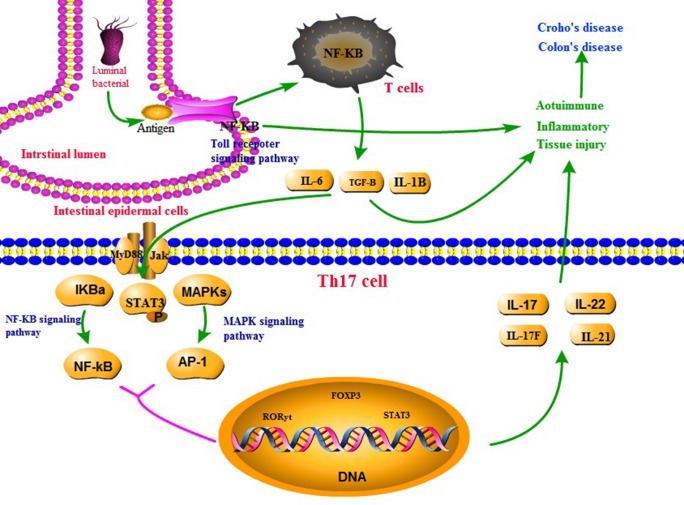
The mechanism of UC.